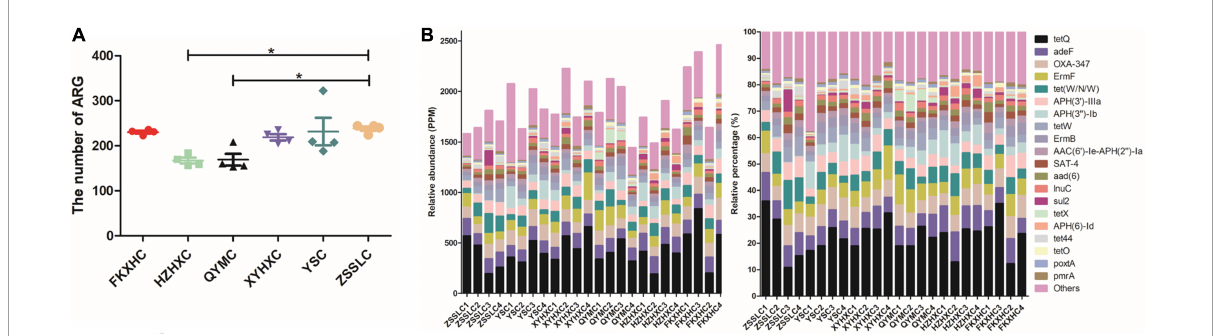
FIGURE5 The abundance of antibiotic resistant gene. (A) Scatter dot plot showing the difference in the number of ARGs among the six groups. (B) The relative abundance in unit PPM of magnifying 10 6 times of original abundance and the percentage of ARGs in each sample.